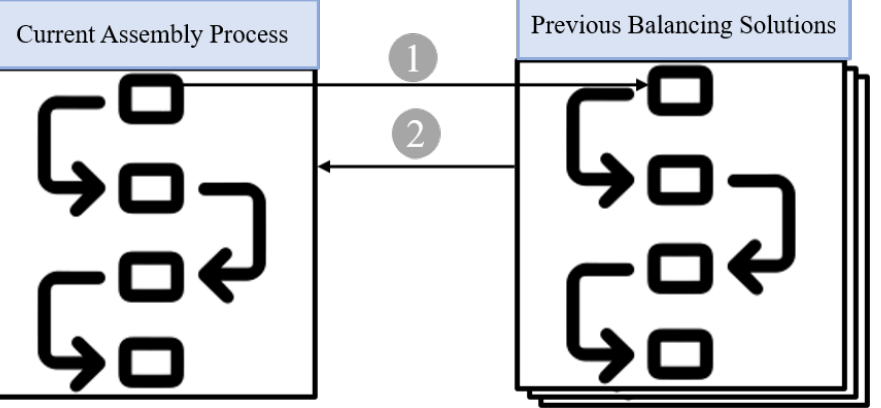
Figure 2. Cognitive assembly line balancing approach based on similarity detection with historic balancing